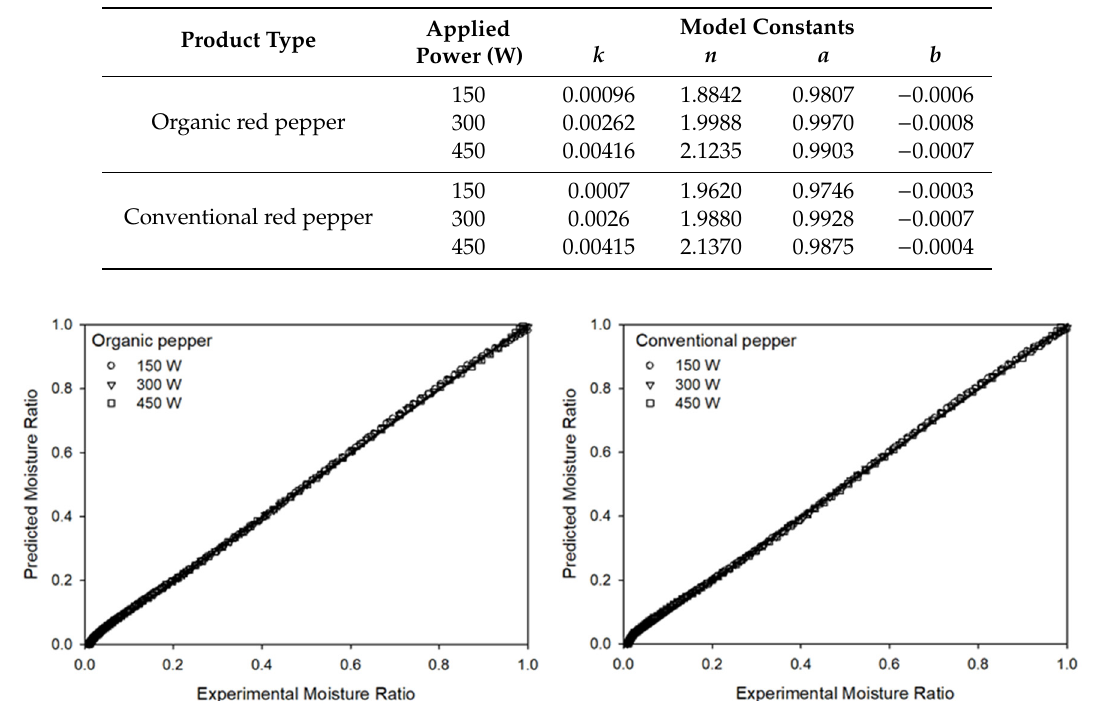
Figure 4. Experimental vs. predicted moisture ratios for different applied intermittent microwave drying powers for organic and conventional sweet red pepper samples.